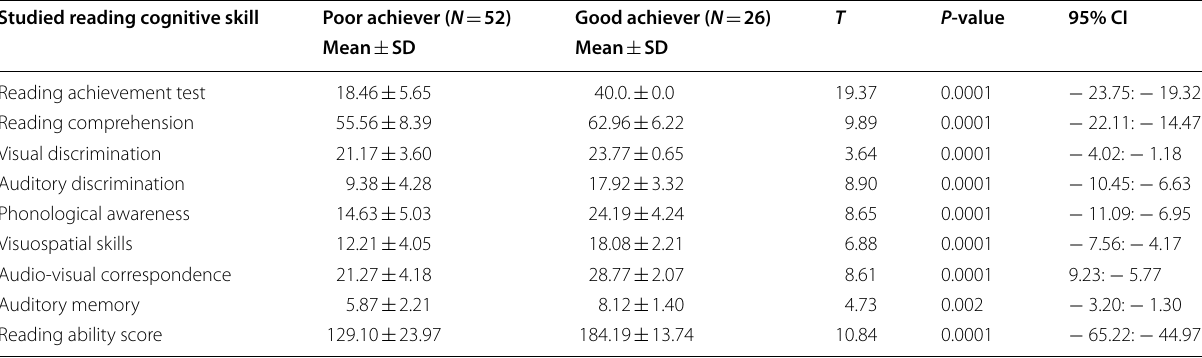
Table 2 Contrasted group validity Studied reading cognitive skill